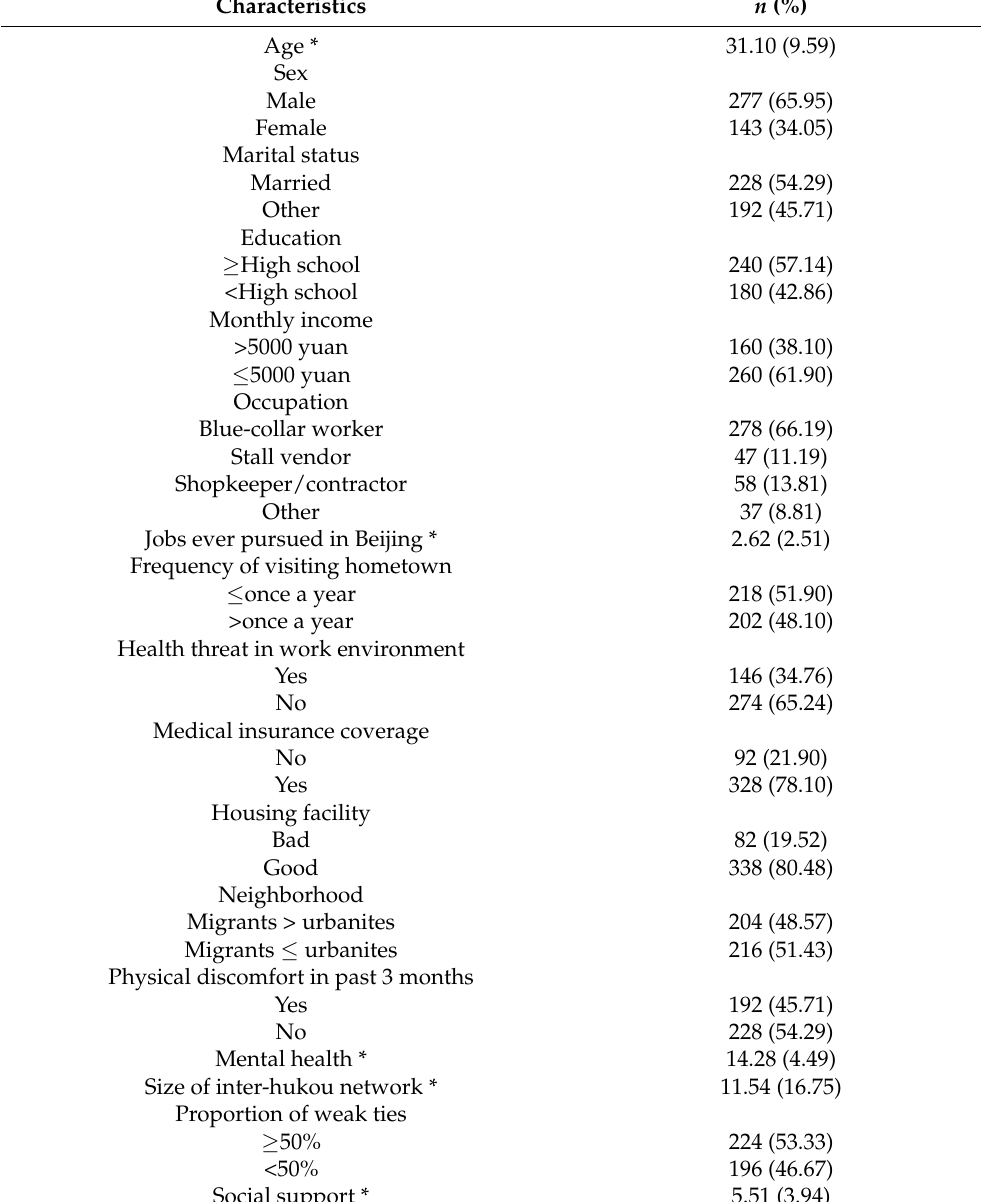
Table 1. Sociodemographic and network characteristics of participants ( n =